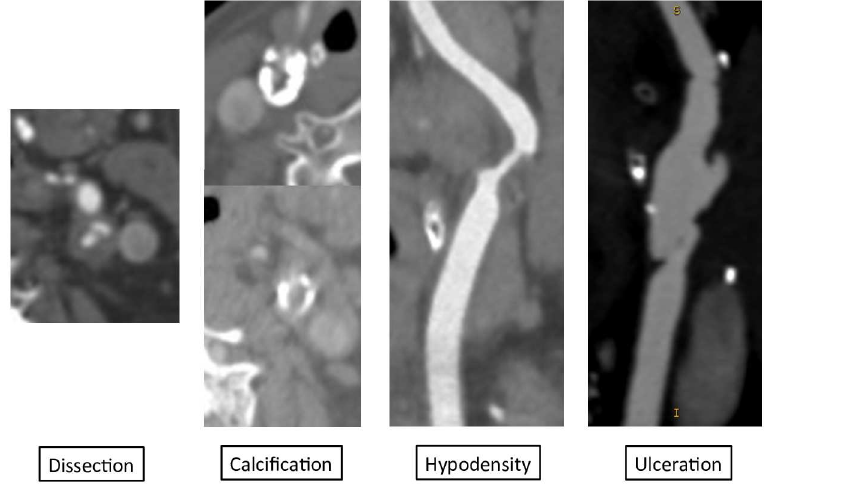
Fig 1. Lesioncharacteristics. Dissection, calcification, hypodensity and